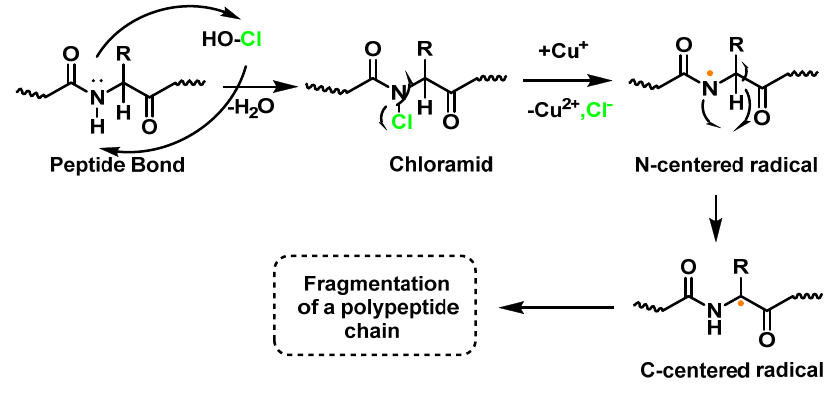
Figure 34. Formation of chloramide.